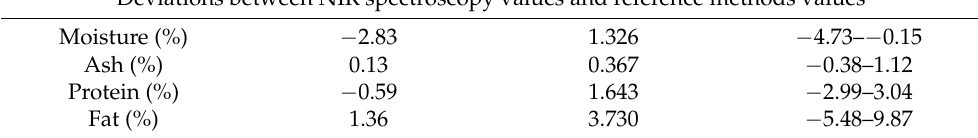
Table 4. Pearson correlation coefficients for measured (Ref) and estimated (NIR) values for moisture, ash, protein, and fat content of traditional sausages were used for the external validation. Parameter Correlation Coefficient Significance Moisture (%)